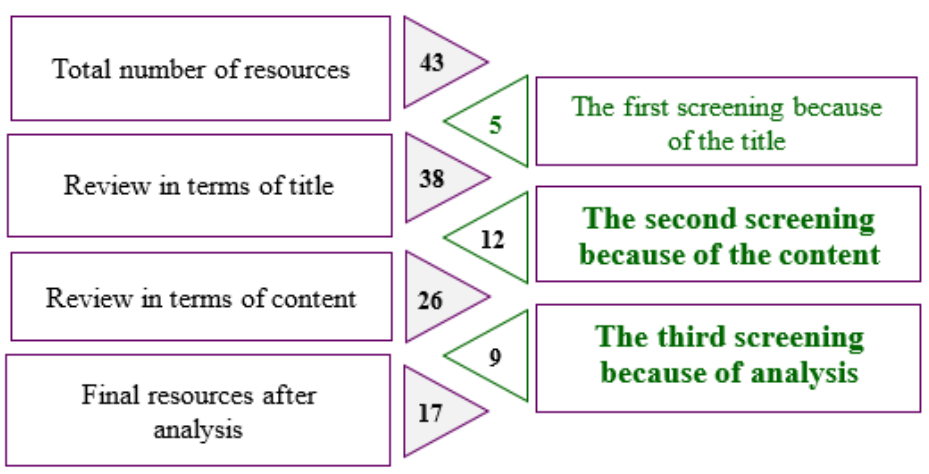
Figure 1. Screening of initial